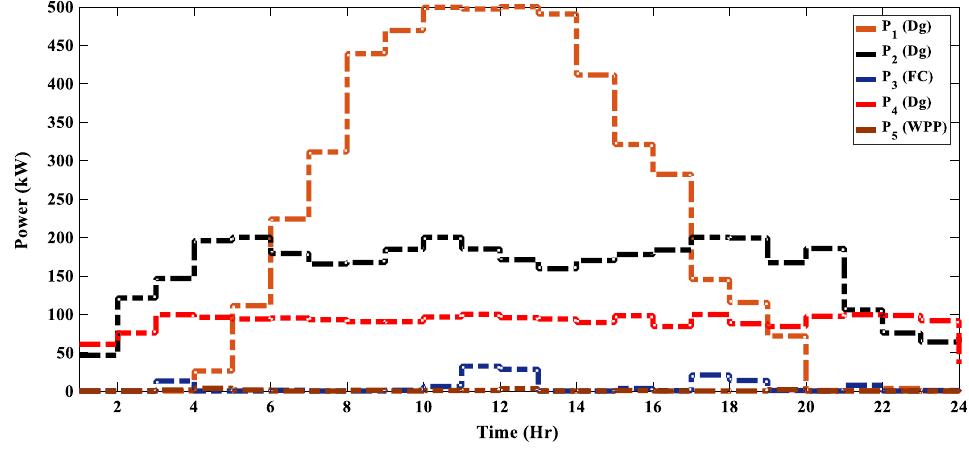
Figure 7. The generation scheduling of MSCHPEED with REI for emission minimization. PPF is the weighted sum method to convert a multiobjective function into a single objective function. TOPSIS is used as a tool to rank the solution on the basis of the distance between positive and negative distance from the ideal solution. Tables 7 and 8 show the top ten optimal front solutions for SCHPEED and MCHPEED problems. The elite solution was selected on the basis of top rank, and the corresponding Pareto fronts are shown in Figure 8, and Figure 9, respectively. Table 4 shows that for SCHPEED, the BCS in terms of the fuel cost of 35.9695 USD/h and the emission of 45.0773 g/kWh was also found to be superior to the reported results by DE [32] and PSO [32]. Considering Table 5, the BCS of 30.3835 USD/h and 44.3393 g/kWh was found to be lower due to REI with a topsis rank of 0.7886 as in Table